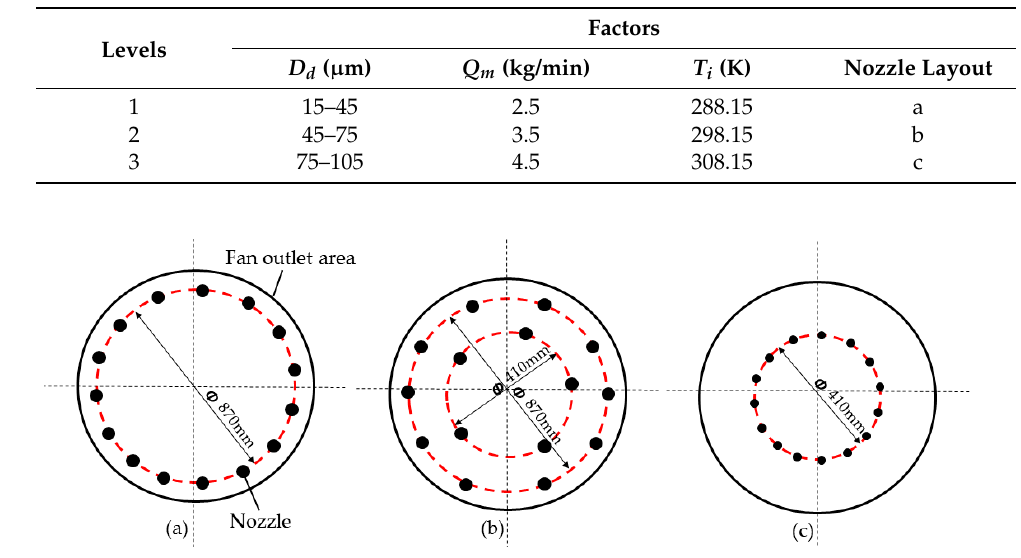
Figure 9. Three layouts of nozzles. ( a )—Large diameter single circle; ( b )—Double loop; ( c )—Small diameter single circle.